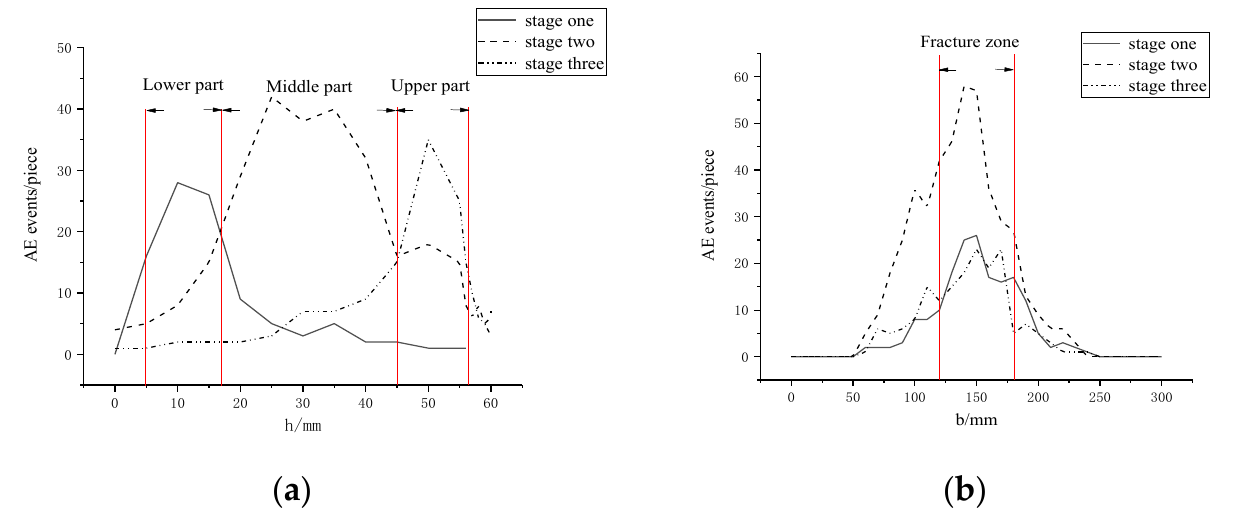
Figure 9. Location distribution of fracture damage: ( a ) longitudinal distribution; ( b ) transverse distribution.